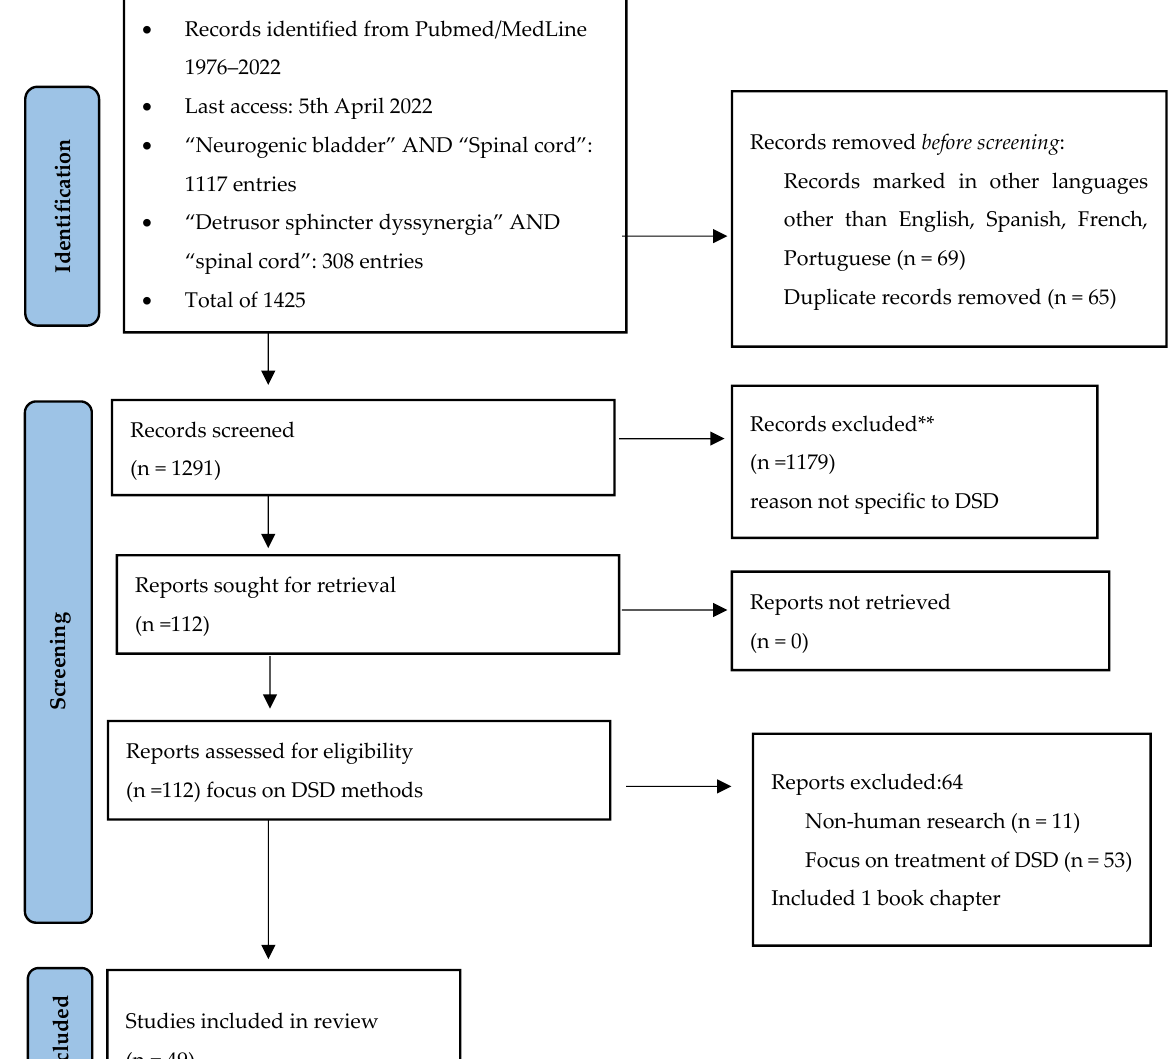
Figure 3. Literature review according to PRISMA flow chart.